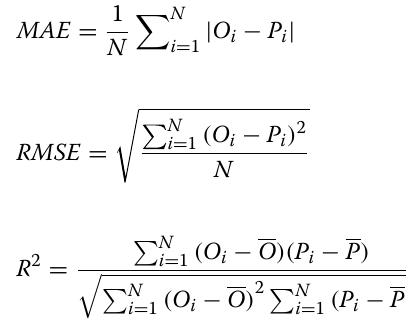
Table 2 Load combination formula based on ASCE Term Design method Chapter of